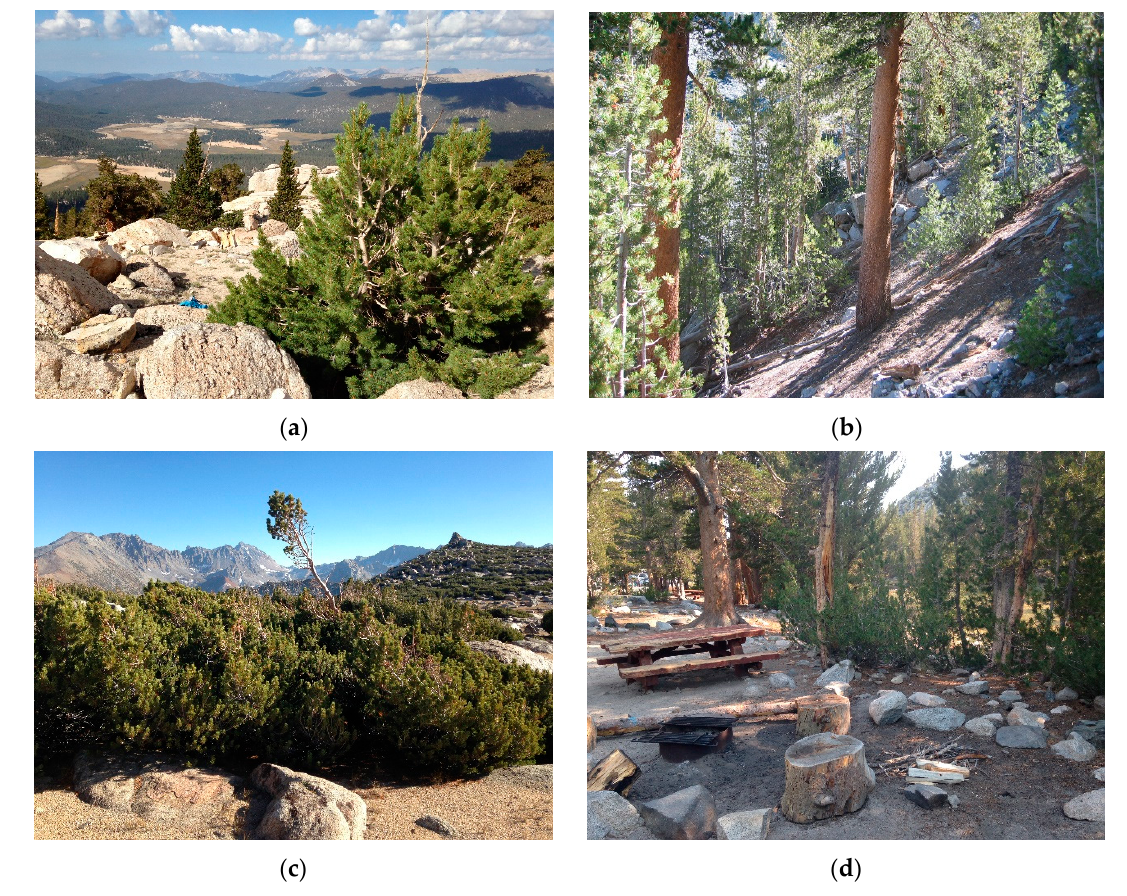
Figure 1. ( a ) Southern-most known whitebark pine population in North America, overlooking the Kern Plateau in southern Sierra Nevada; ( b ) study plot in the Glass Mountains, at the lower elevation range limit, where whitebark pine occurs with lodgepole pine; ( c ) study plot in Bishop Creek of the Sierra Nevada, at the upper elevation range limit, and ( d ) a campground included in the recreational study site at Rock Creek.